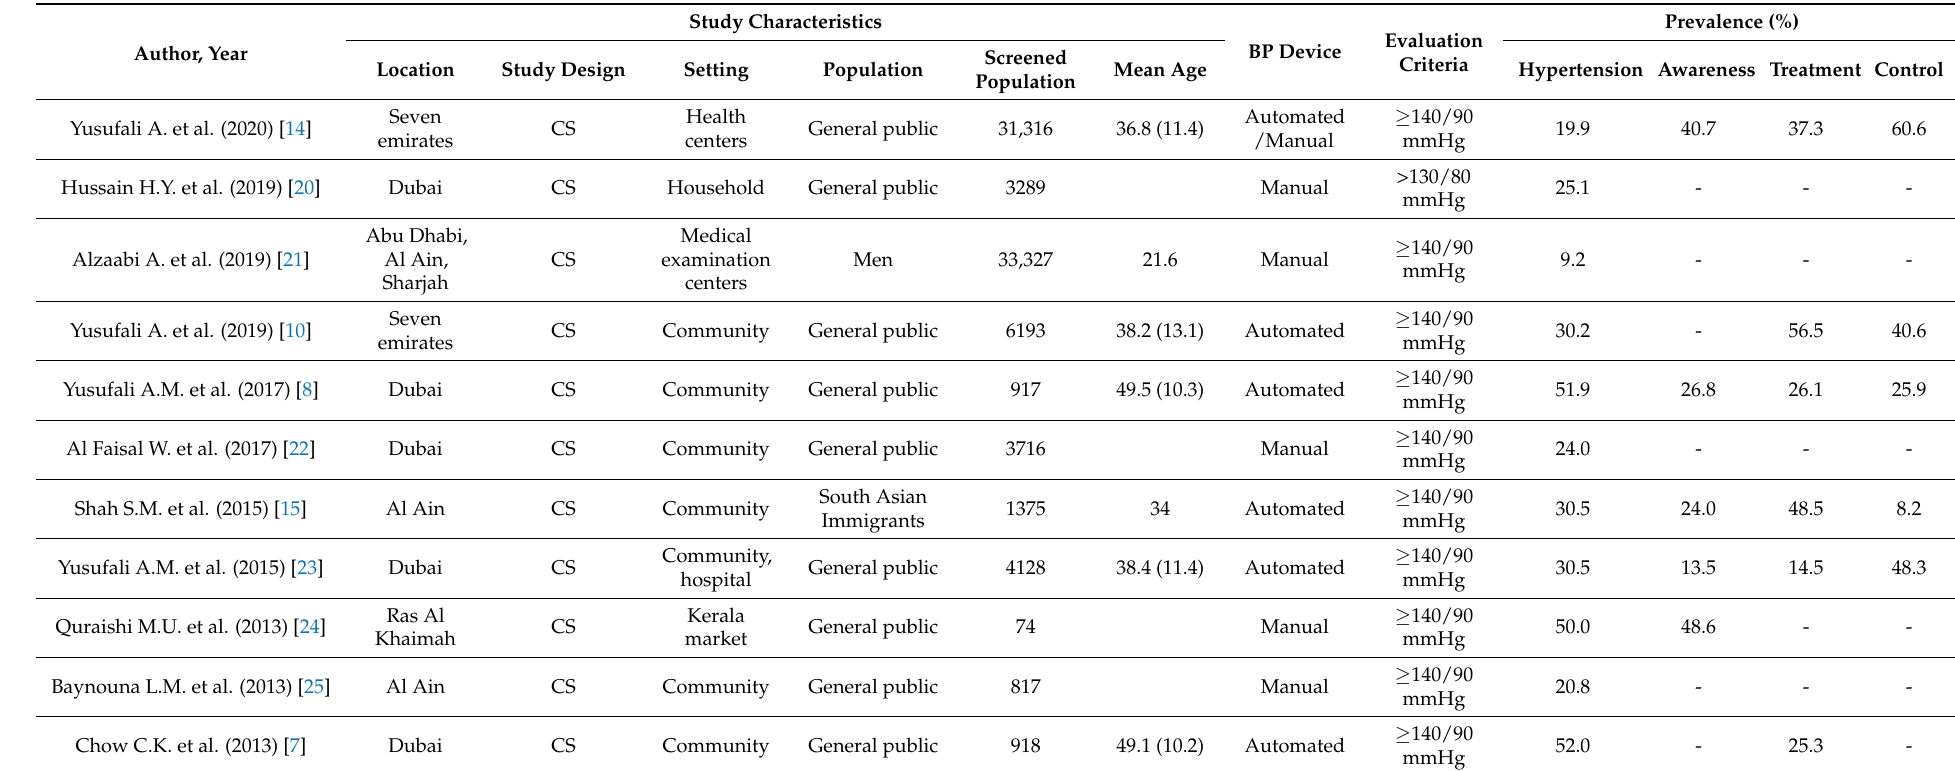
Table 1. Characteristics of the included